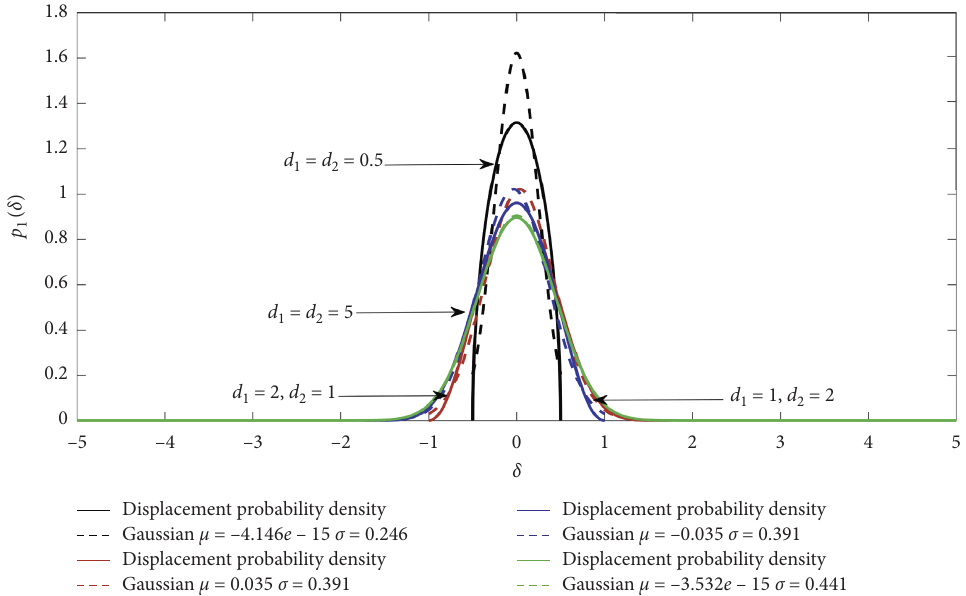
Figure 7: Displacement PDFs of ATNPS for various values of packaging material